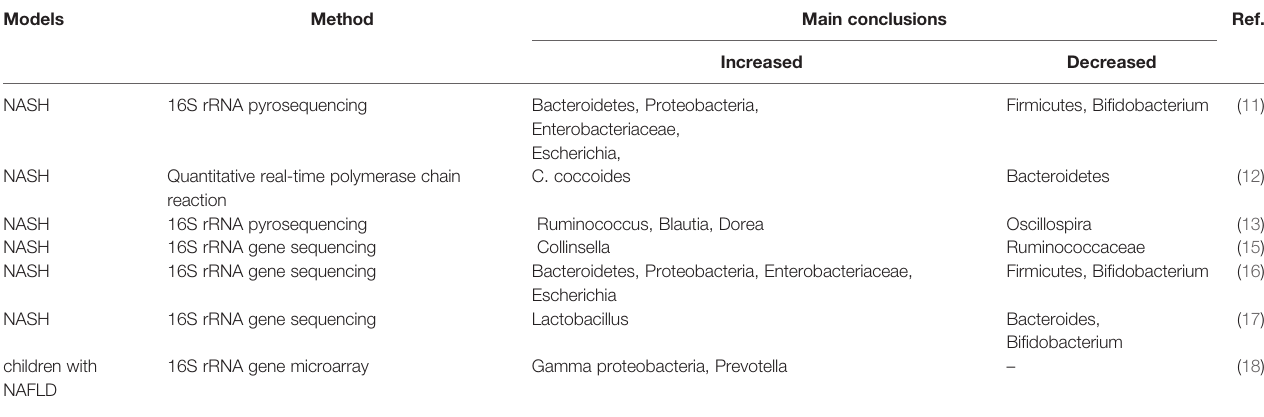
TABLE 1 | Composition of intestinal microbiota in NASH